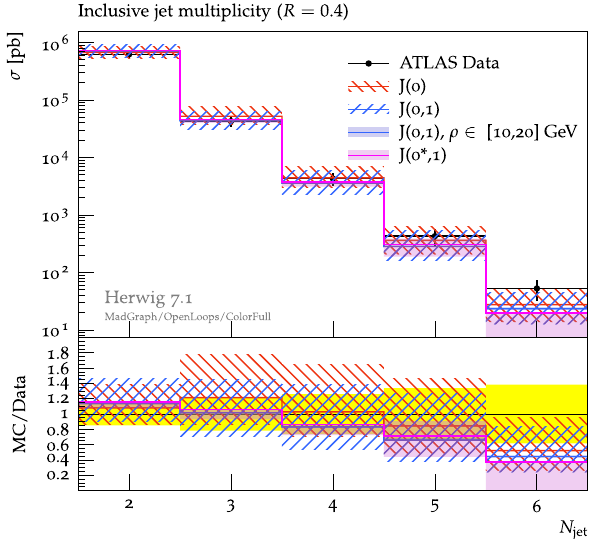
Fig. 26 The transverse momentum of the hardest jet should hardly be altered by the merging algorithm as the observable is already described at LO. The uncertainty estimates from scale variation is not altered by the merging process